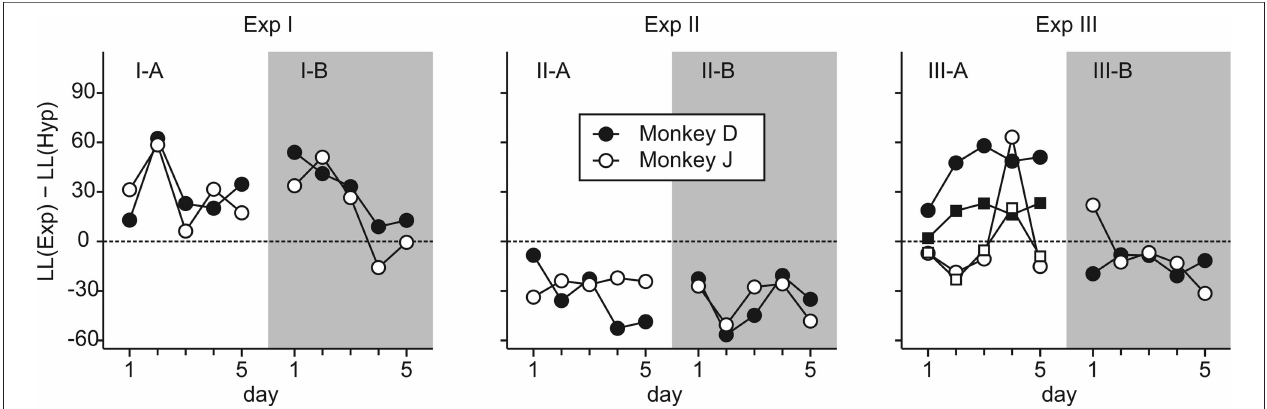
( Figure 4 ). For an exponential discount function, the temporally discounted value would be reduced by 50% for the delay equal to − (1/ k ) log 0.5. Therefore, the approximate half-life for the subjec- E tive value of a reward was 2.2–2.4